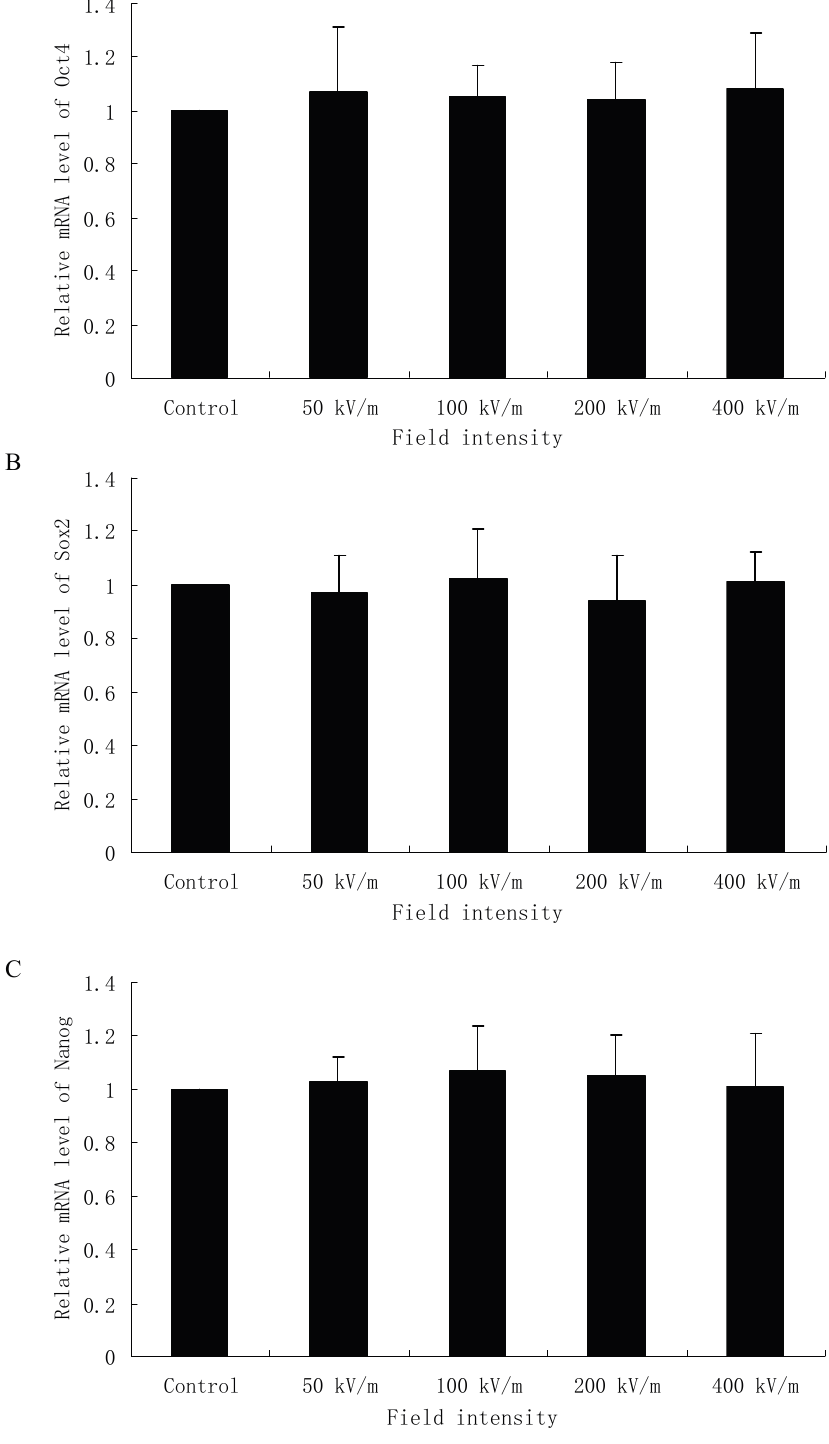
Figure 2. Real-time polymerase chain reaction analysis of Oct4 ( A ), Sox2 ( B ) and Nanog ( C ) gene expression in HUES-17 human embryonic stem cells (hESCs) after exposed to PEMF at different electric field intensities (control group, 50, 100, 200, 400 kV/m). The expression value of each gene was normalized by an internal control gene glyceraldehyde-3-phosphate dehydrogenase ( GAPDH ). The expression level of each gene in the control group is arbitrarily defined as one unit. Results were obtained from three independent experiments and expressed as mean ± SD ( n = 3 in each